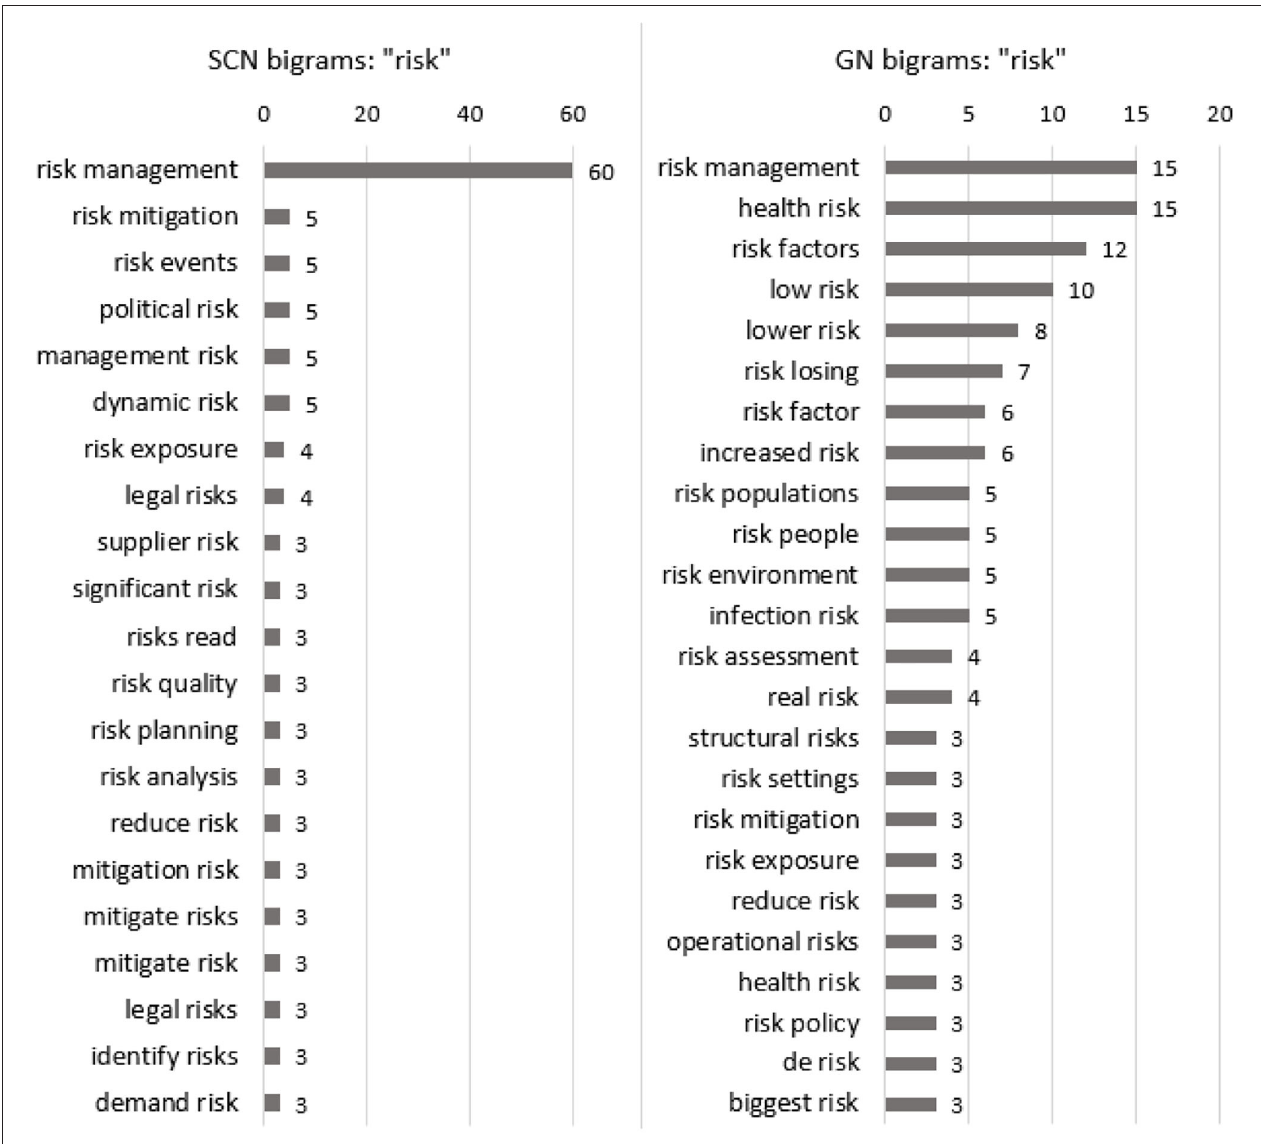
FIGURE 11 | Bigram